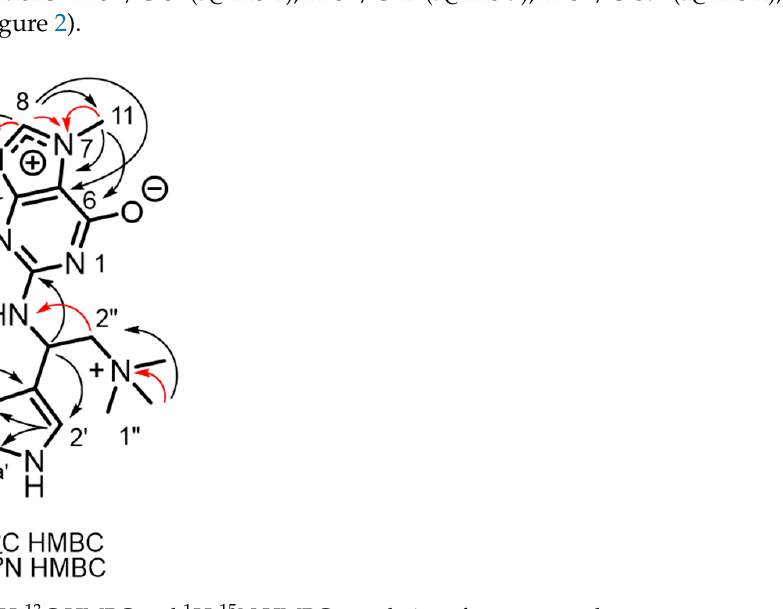
Figure 2. Key 1 H- 13 C HMBC and 1 H- 15 N HMBC correlations for compound 1 .